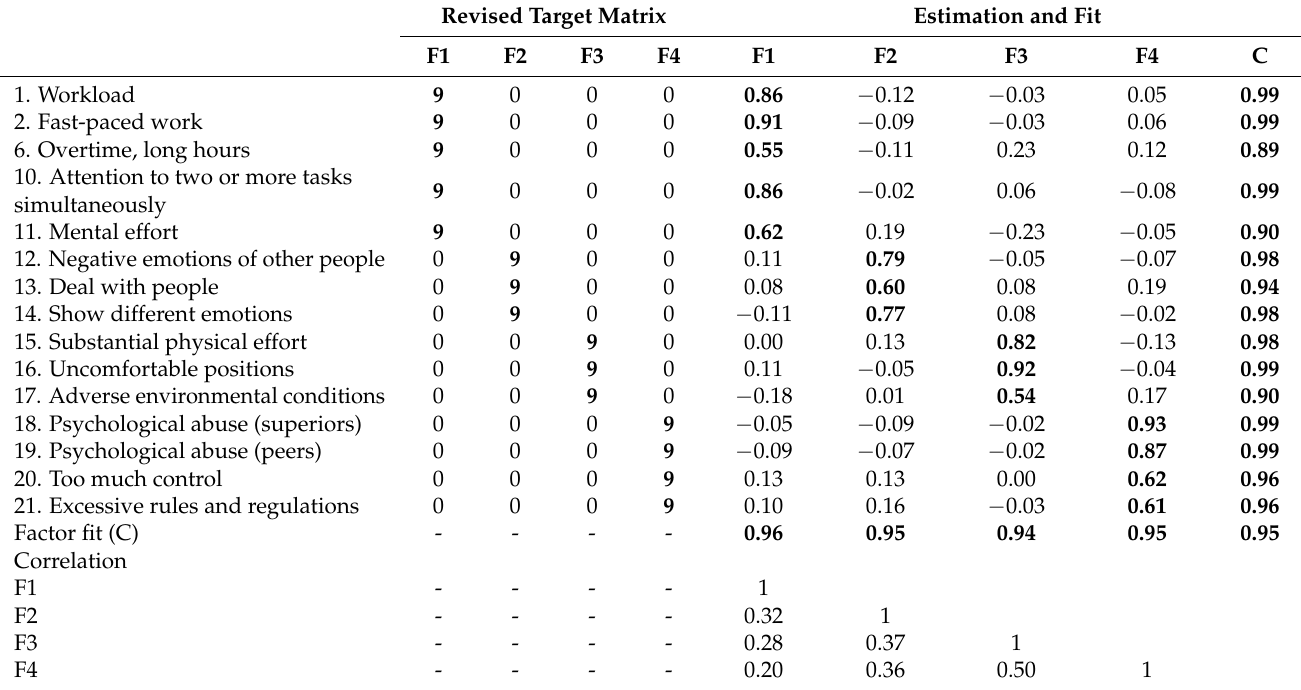
Table 5. Psychosocial risk factors: final iteration (n =